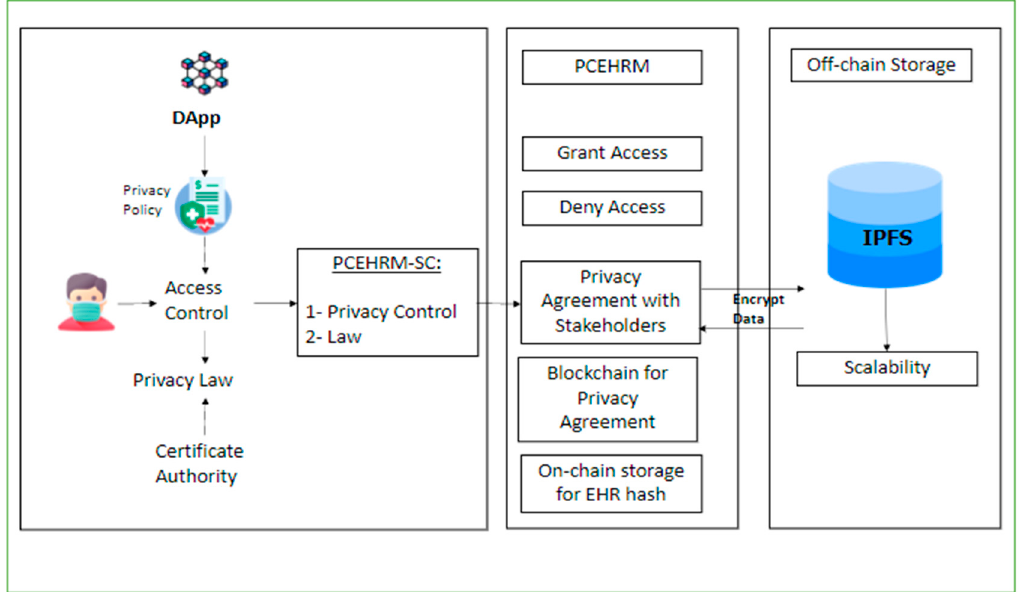
Figure 2. Framework of the proposed system.